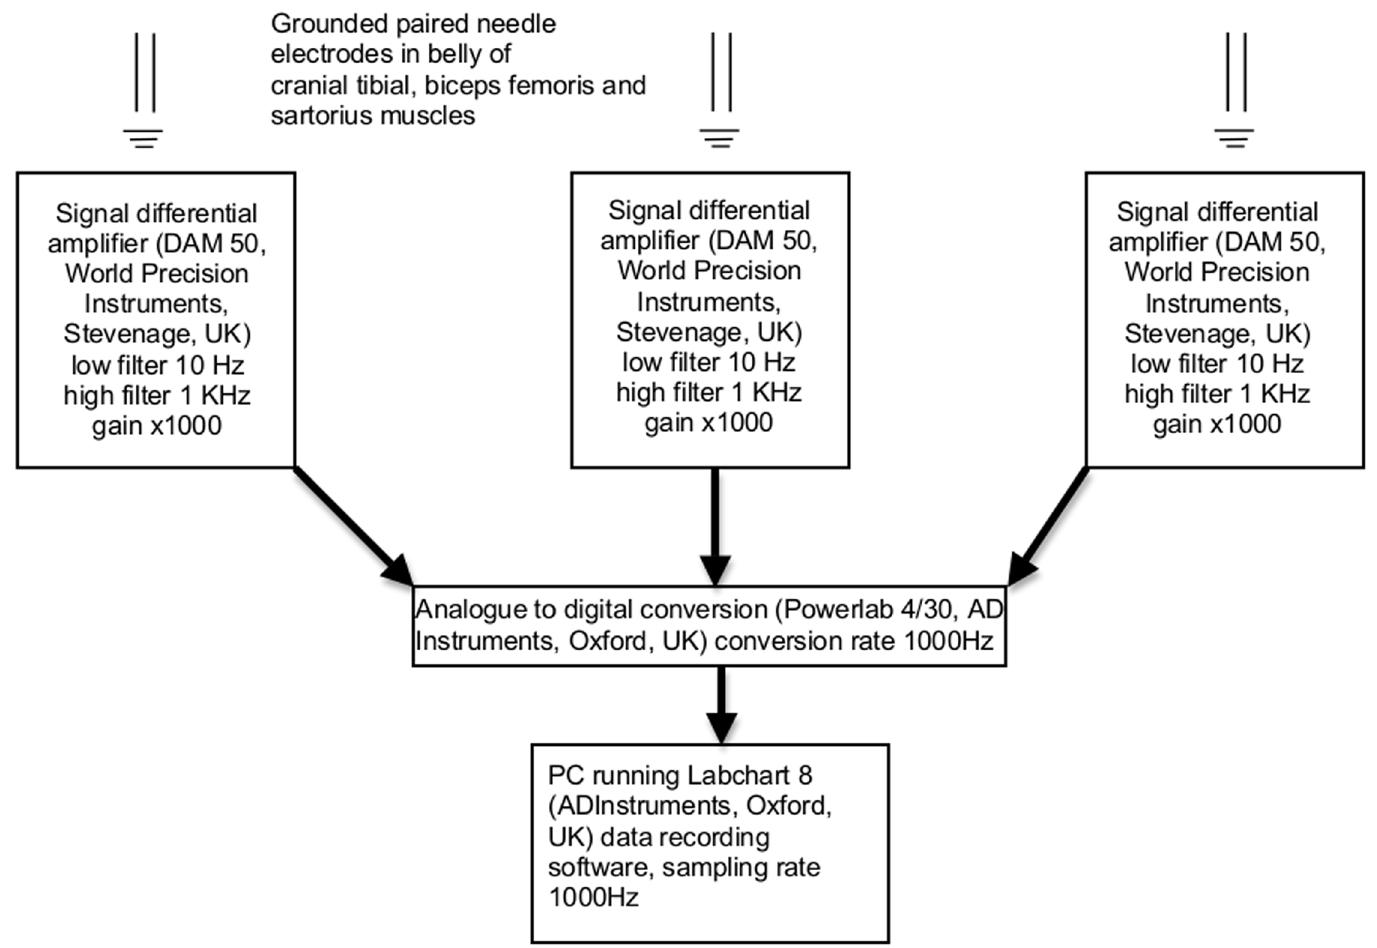
Fig 2. Schematic, illustrating recording